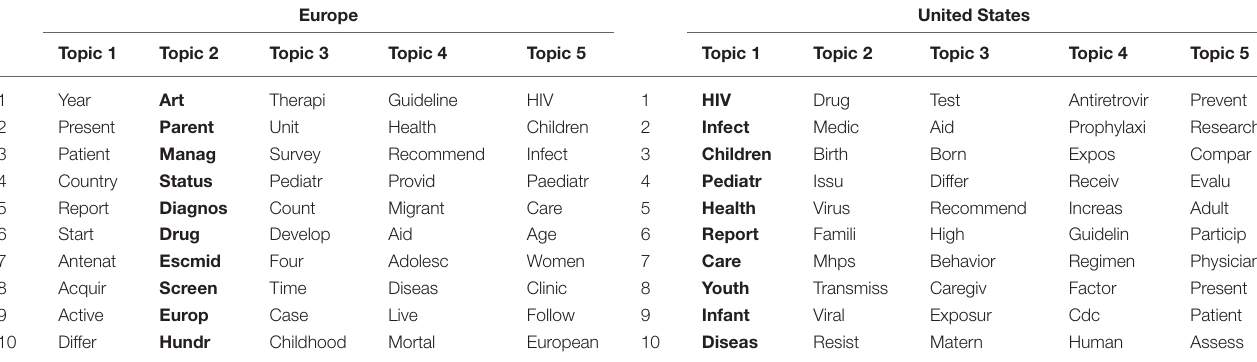
TABLE 4 | Topic models for European and US-based studies of